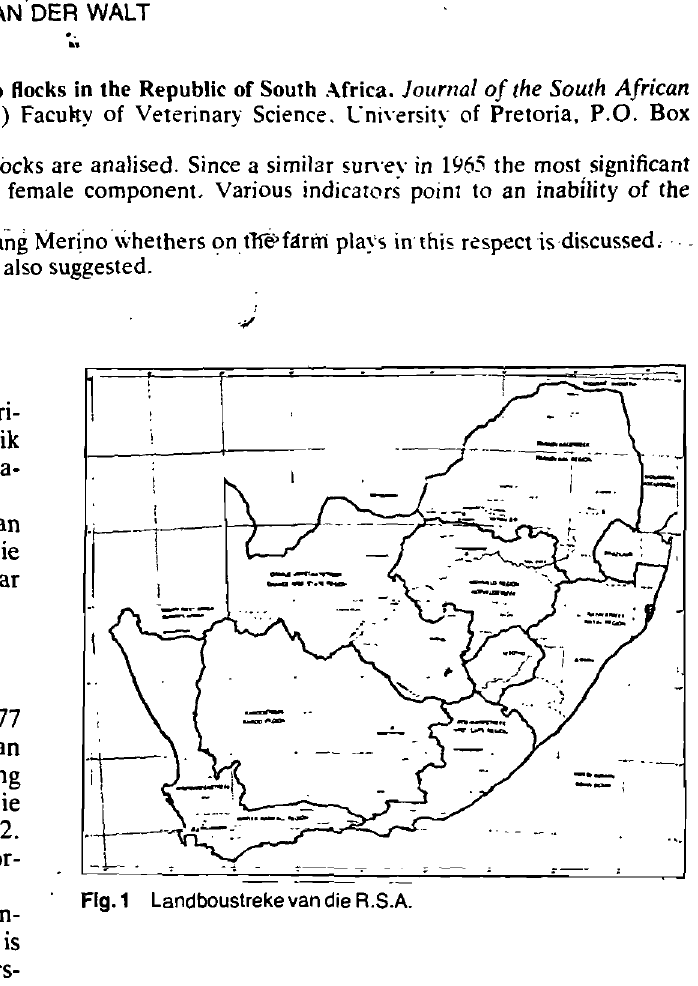
FIg. 1 Landboustreke van die